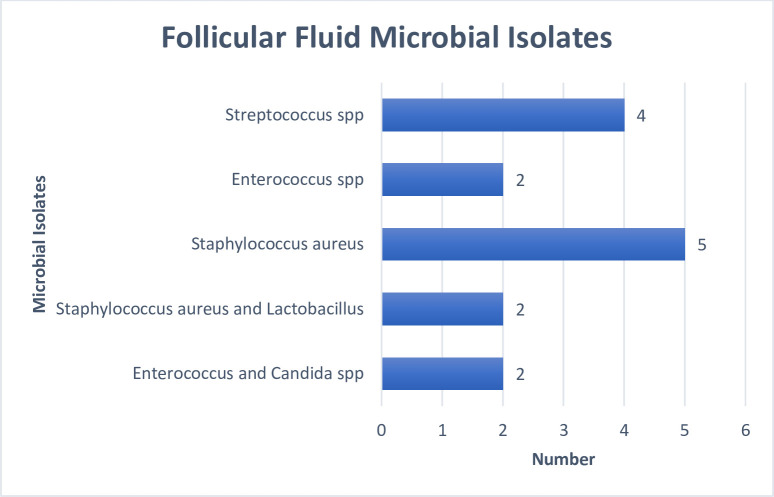
Frequency distribution of the follicular fluid microbial isolates.